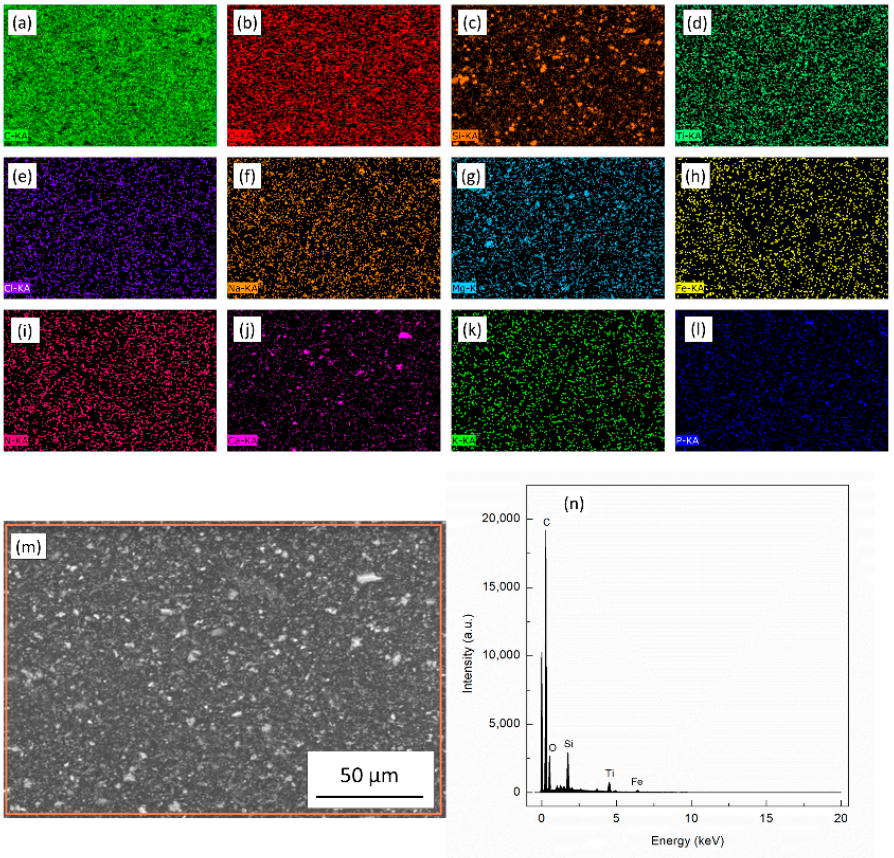
Figure 2. EDX mapping for ( a ) carbon, ( b ) oxygen, ( c ) silicon, ( d ) titanium, ( e ) chlorine, ( f ) sodium, ( g ) magnesium, ( h ) iron, ( i ) nitrogen, ( j ) calcium, ( k ) potassium, and ( l ) phosphorus for the epoxy coating on carbon steel plates. The SEM micrograph ( m ) displays the area analyzed and the spectrum with major peaks is shown in ( n ).